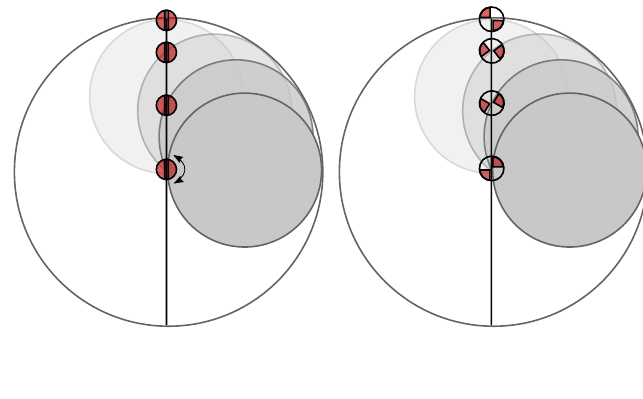
Figure 20. Alternative realizations of the VSM concept. One uses a pin with a groove; the other uses a fixed cylindrical pin with two quarter cylinders cut away (white